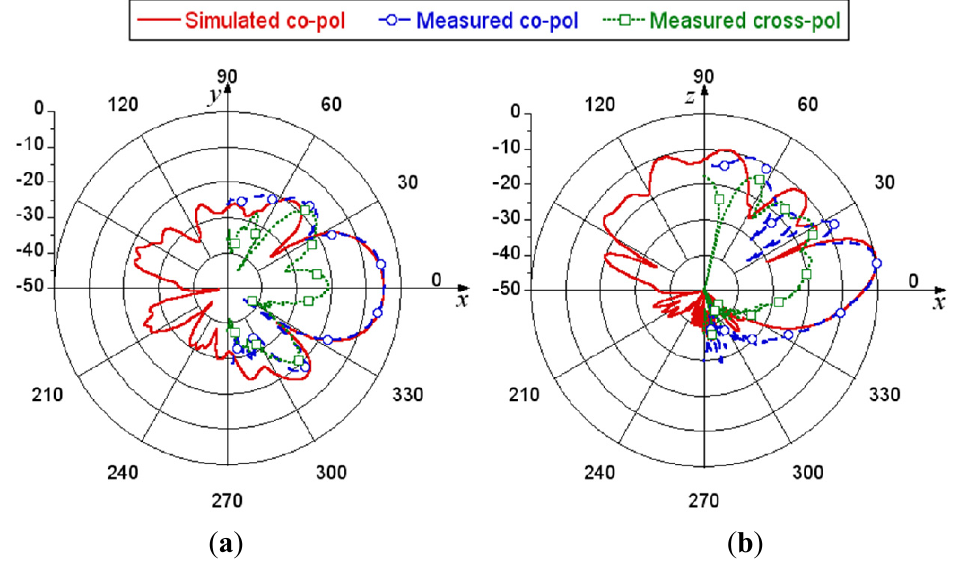
Figure 6. Measured and simulated radiation patterns of the antenna placed at a distance h = 5.6 mm from the skin-equivalent phantom at 60 GHz: ( a ) E - and ( b ) H -planes.